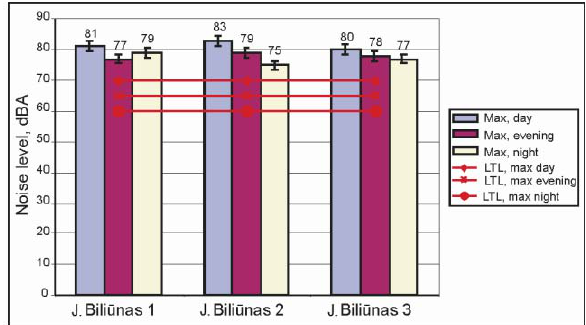
Fig. 21. Dynamics of maximum noise levels in J. Biliūnas street within twenty four